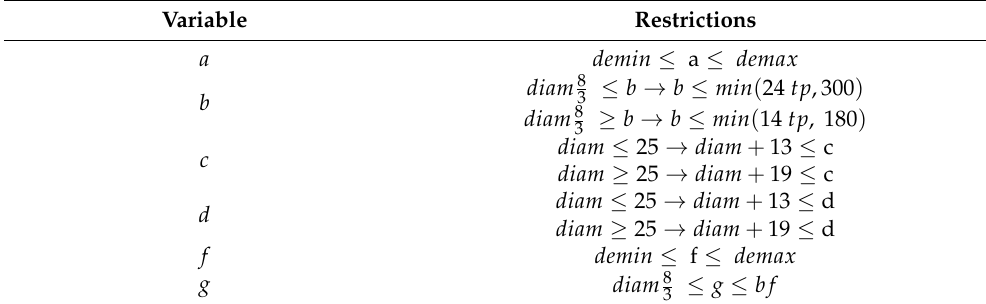
Table 2. Variable constraints of the connection plate geometry. Source: the authors.